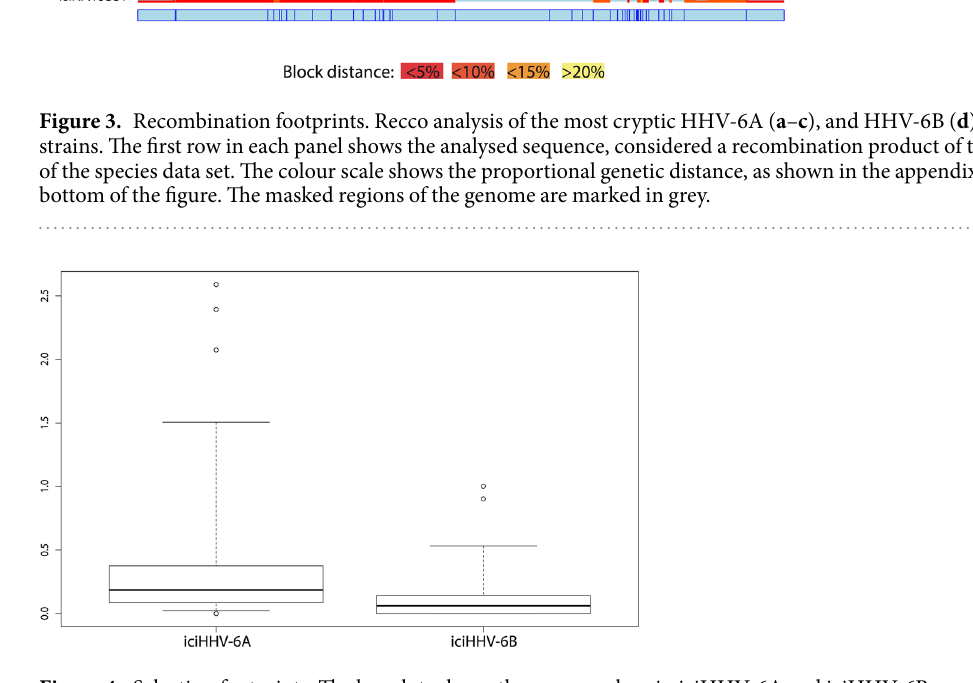
fixed to 1, a value considered a threshold to identify positive selection (Table 2). Two genes stood out for high dN/ dS ratio in iciHHV-6B: U90 and U100 , with an ω value of 0.90, and 1.00 respectively. iciHHV-6A showed more diversity than its sister species, increasing the power to detect signatures of selection. There was no clear pattern of sequence constraints when observing the distribution of the ω values along the genome, with the exception of the IE-A region ω values tended to be higher. The highest ω values supported by LTR analysis was obtained for